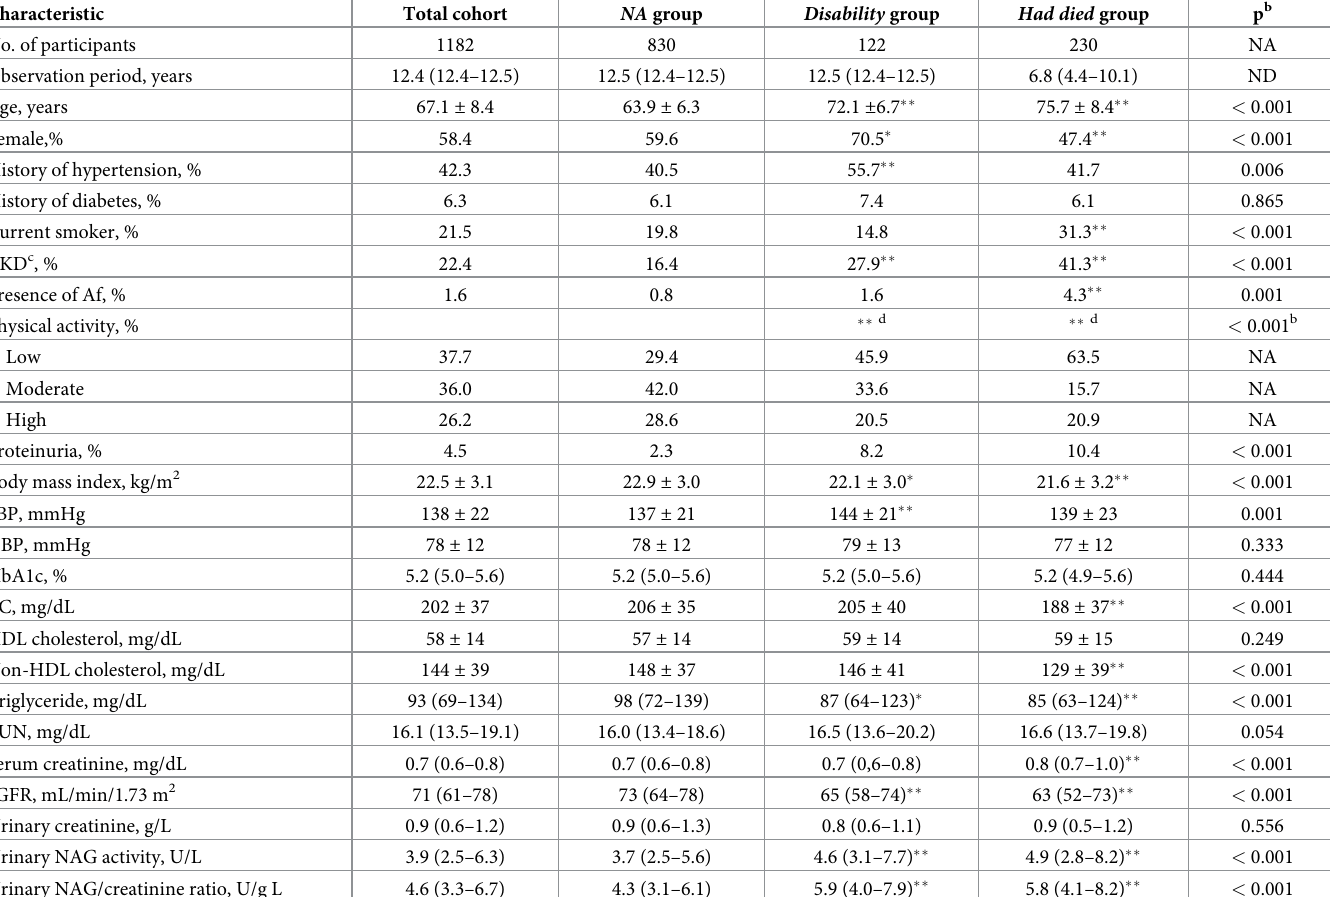
Table 1. Baseline characteristics of the participants not receiving long-term care and not reported to have died ( NA group), participants receiving long-term care ( Disability group), and participants reported to have died ( Had died group) a .